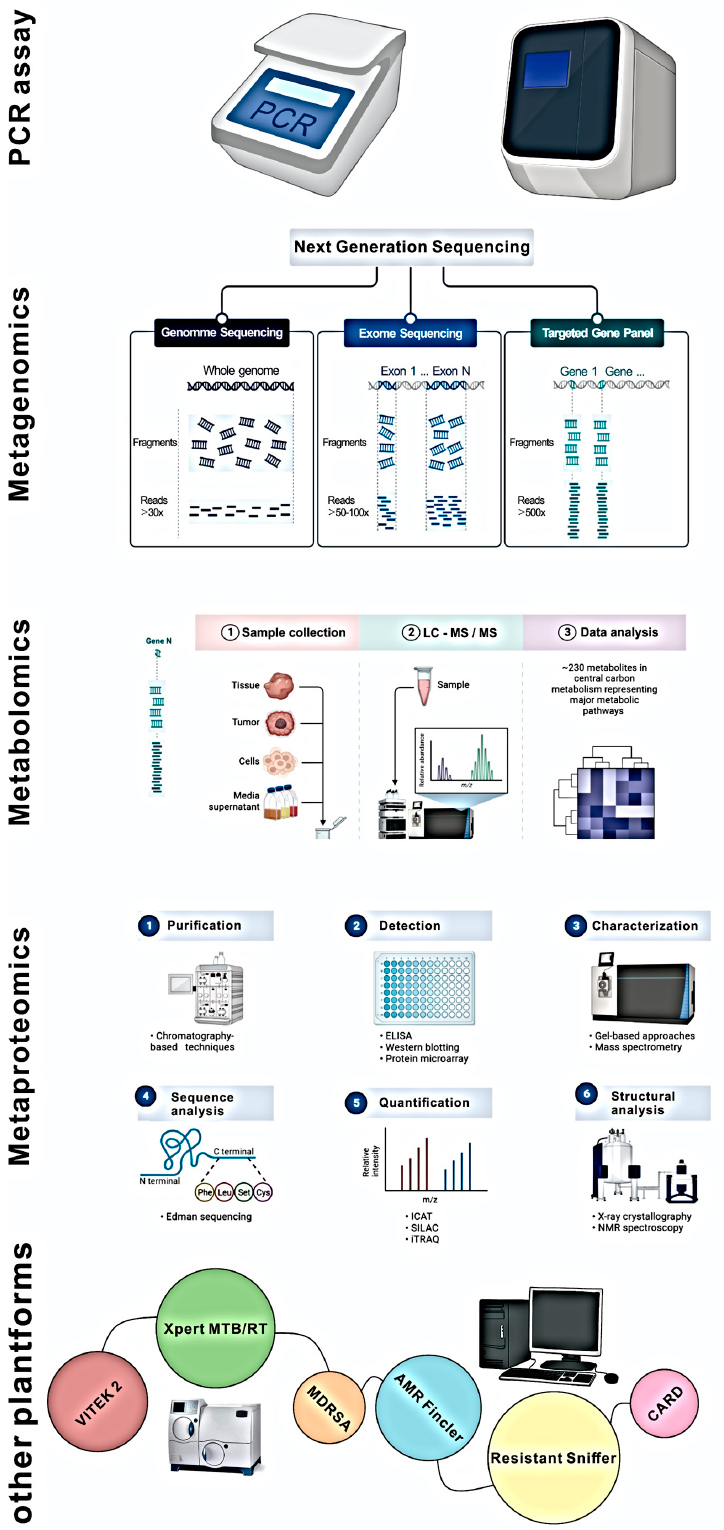
Figure 3. Modern tools used for resistome identification analysis.